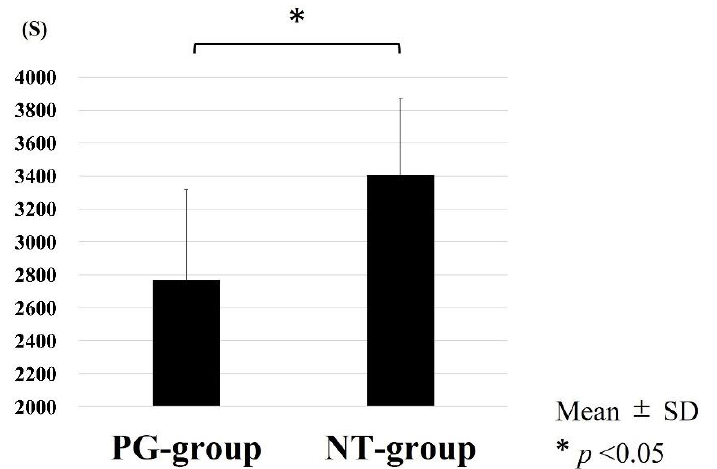
Figure 5. Time to running exhaustion. Running time of the PG group is significantly lower than that of the NT group.